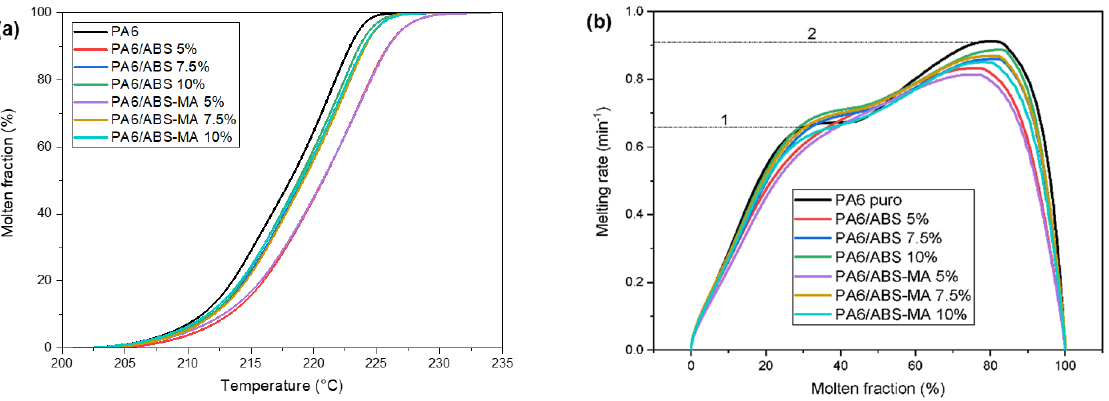
Figure 16. ( a ) Molten fraction of crystals; ( b ) melting rate as a function of the molten fraction of crystals.